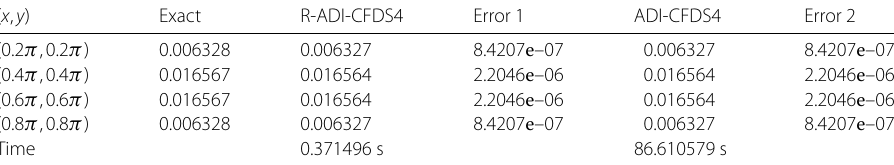
Table 13 Numerical results of SP 3 at time t = 2, with h x = h y = 0.02 π , τ = 0.02 ( x , y ) Exact R-ADI-CFDS4 Error 1 ADI-CFDS4 Error 2 (0.2 π ,0.2 π